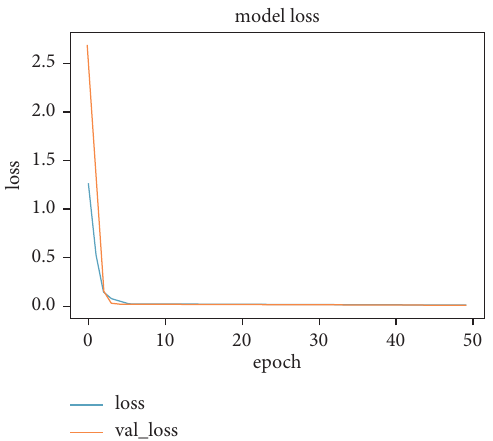
Figure 17: The loss rate of action idea EEG in static state during model training.